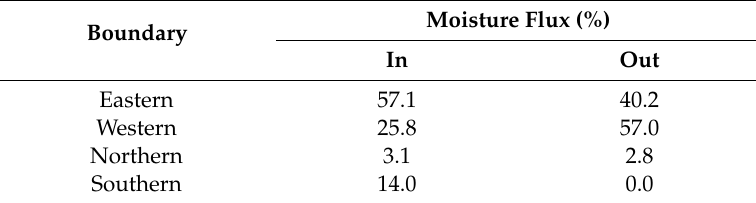
Table 3. Percentages of the moisture in- and outfluxes from each boundary. Moisture Flux Boundary